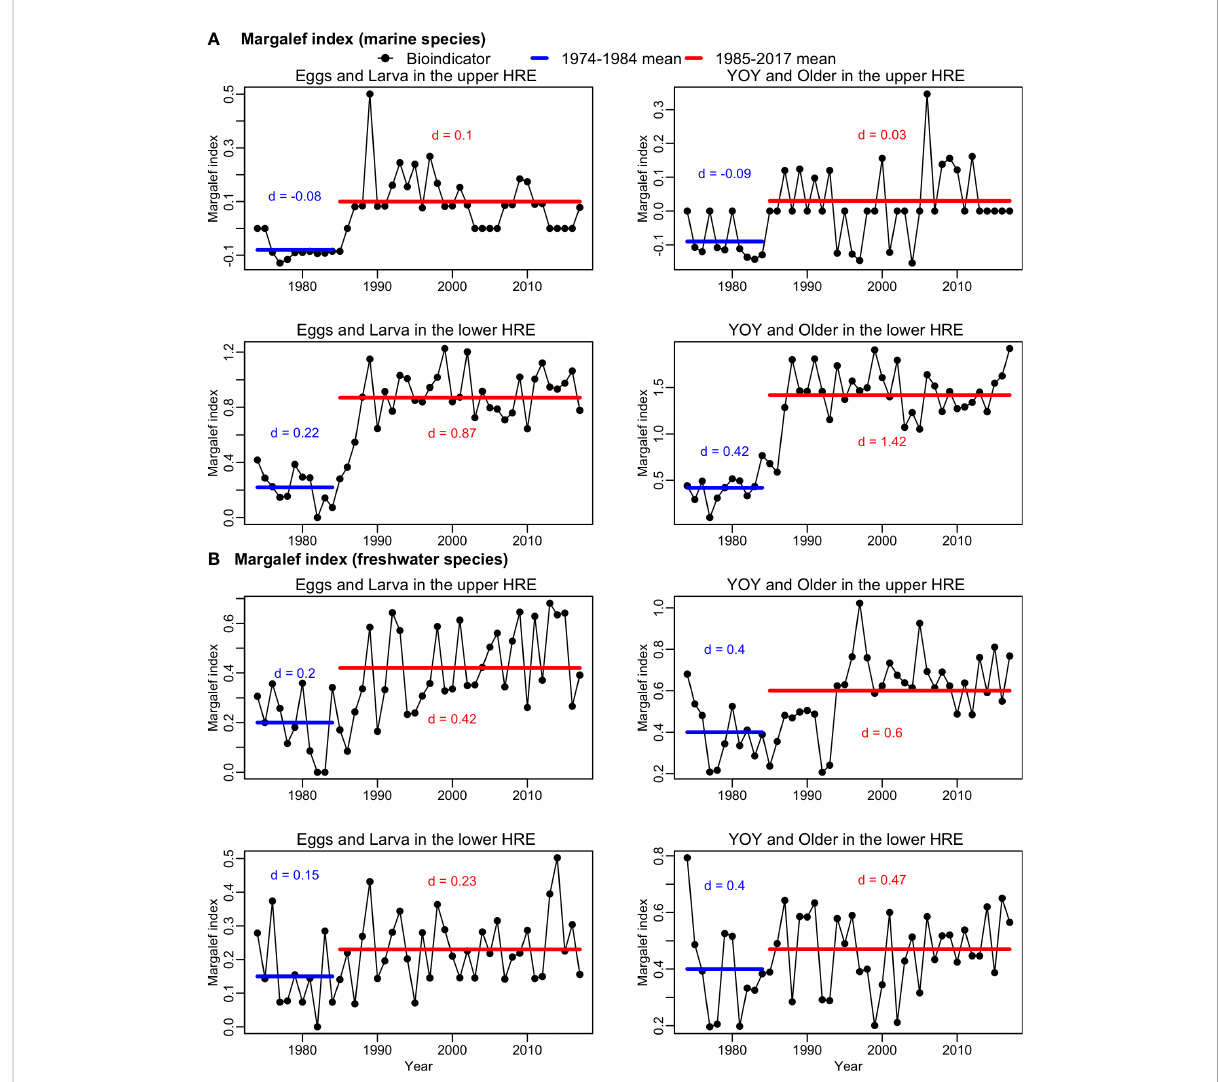
FIGURE 6 Time series of Margalef index for (A) marine species ( d marine ) and (B) freshwater species ( d freshwater ) of early (eggs and larva) and older (young-of-year [YOY] and older) life stages during May-July from 1974-2017 in the upper and lower Hudson River Estuary (HRE). The blue horizontal lines indicate the average numbers of species in phase 1 (1974-1984), and the red horizontal lines indicate the average numbers of species in phase 2